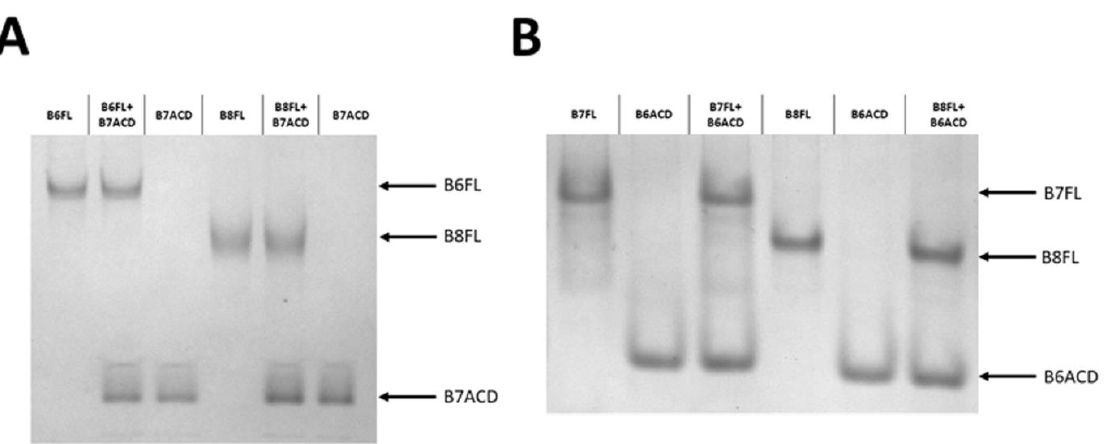
Figure 8. ( A ) Interaction of full-length HspB6 (B6FL) and HspB8 (B8FL) with B7ACD, analyzed by native PAGE. ( B ) Interactions of full-length HspB7 (B7FL) and HspB8 (B8FL) with B6ACD. The po- sitions of the full-length proteins and α -crystallin domains are marked with arrows.